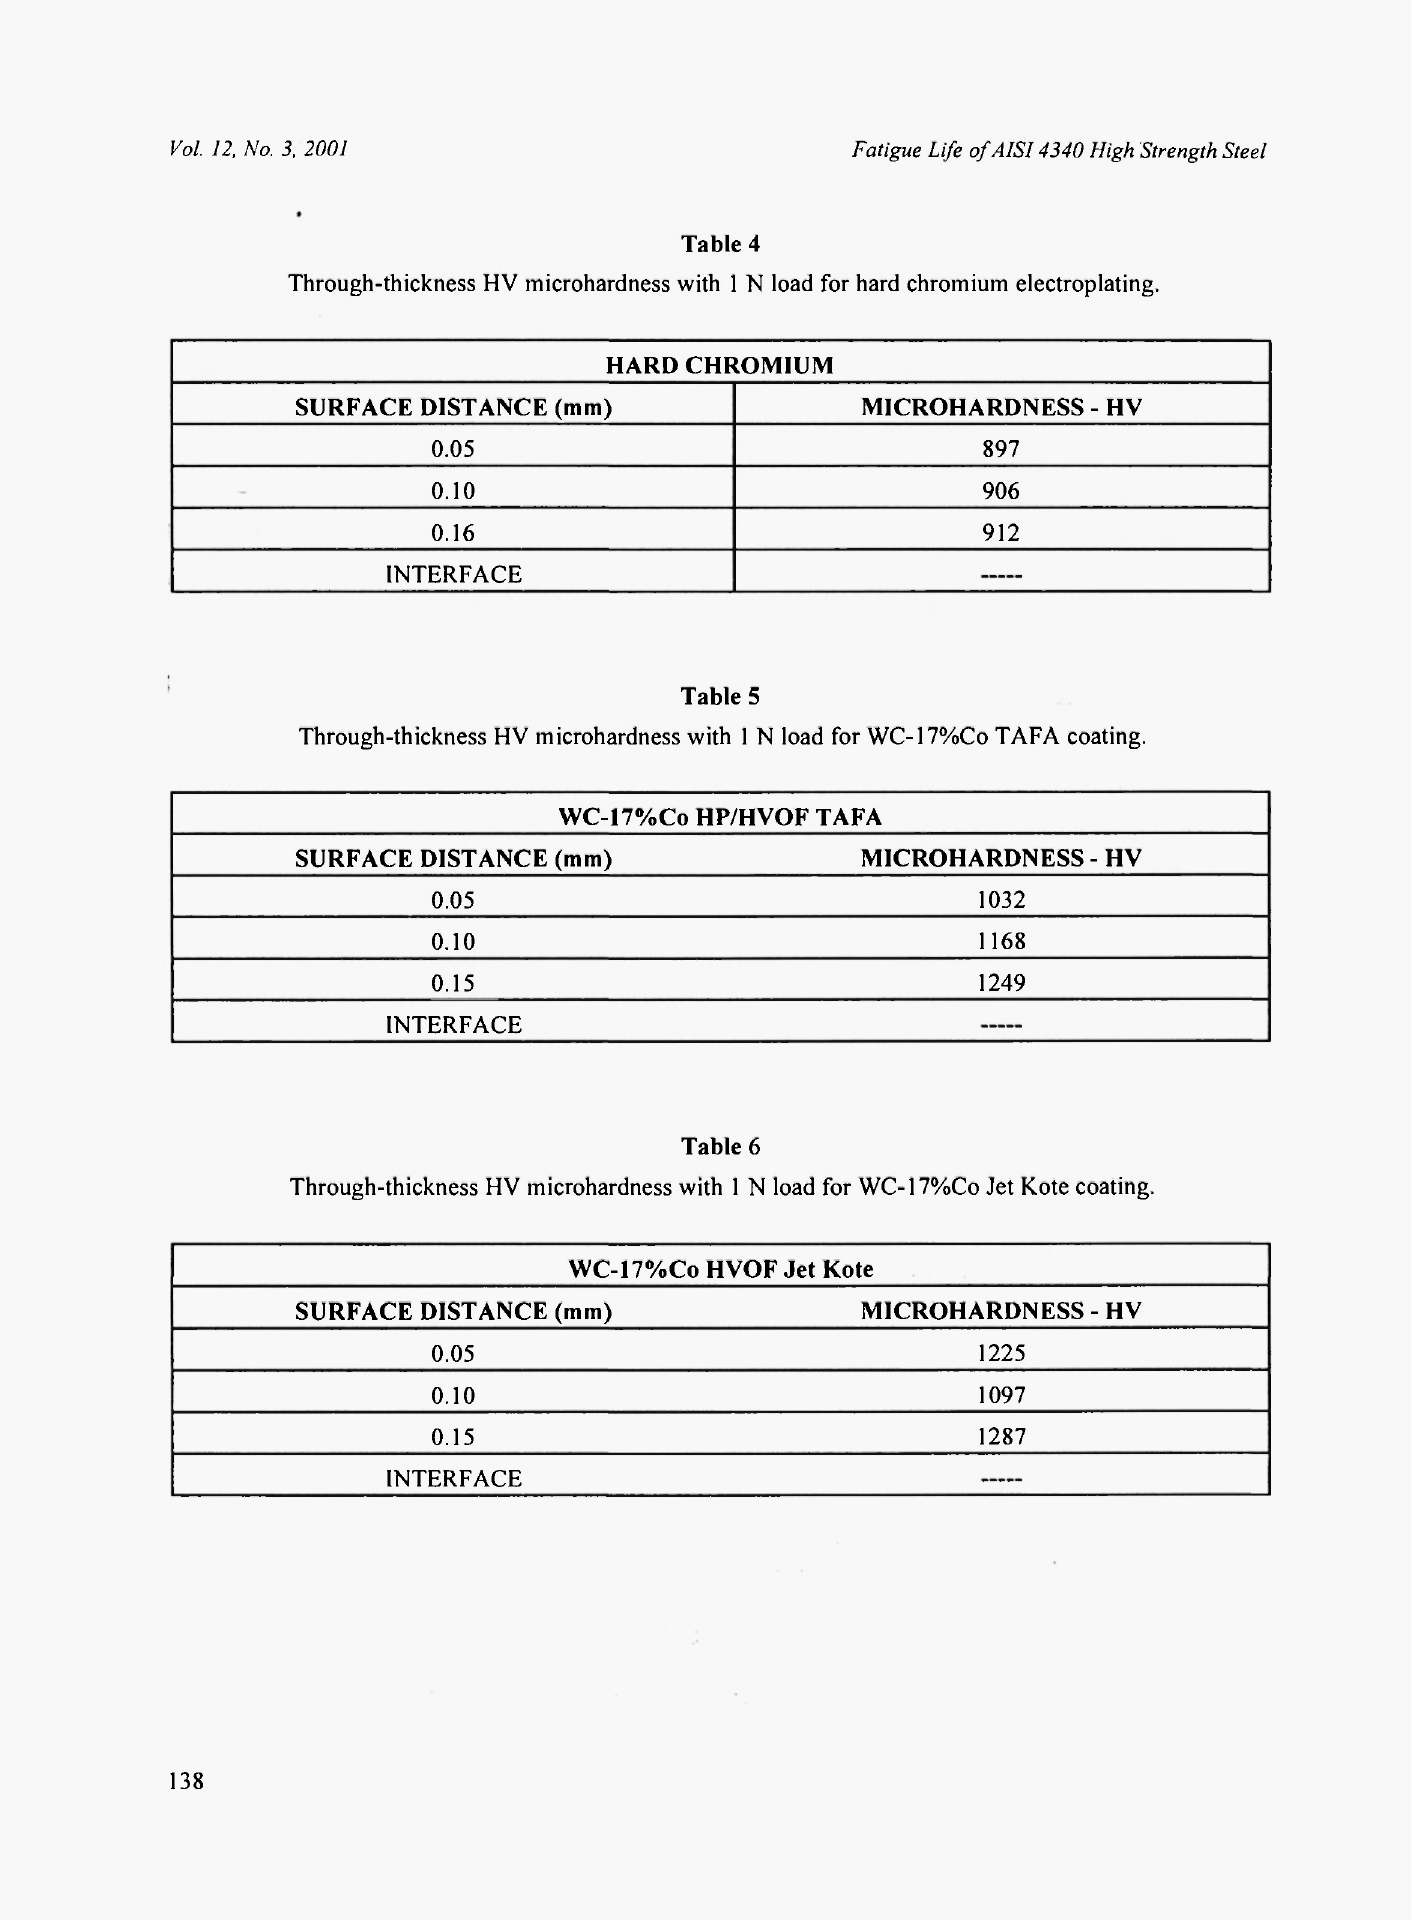
Through-thickness HV microhardness with 1 Ν load for WC-17%Co Jet Kote